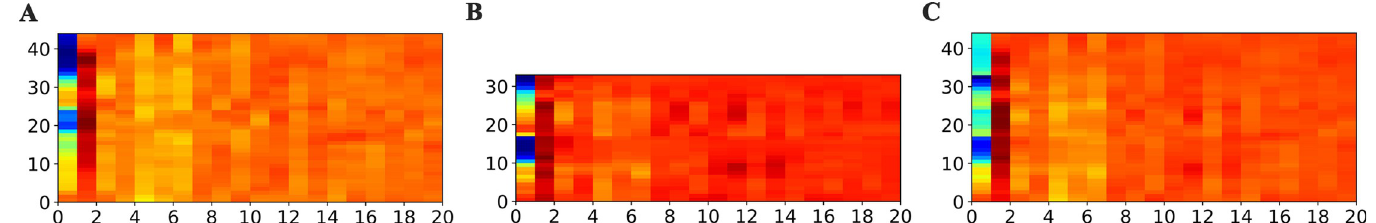
Fig 11. MFCC features on the heat map. (A) and (B) show the MFCC representations of the two cough chunks in one patient audio, and (C) shows the aggregated feature matrix of the patient audio. (A) Chunk a; (B) Chunk b; (C) Aggregated features A&B.